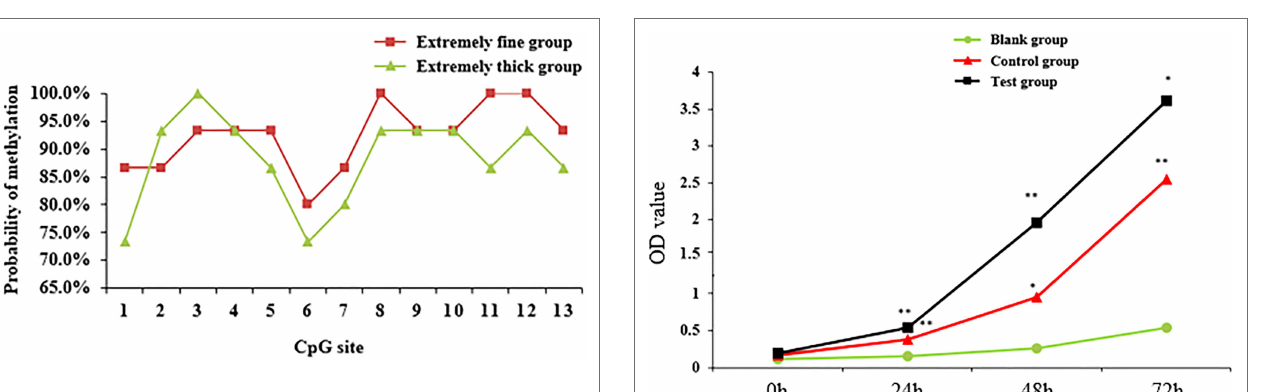
FIGURE 10 | DNA methylation level of CpG loci of WNT2 gene in skin tissue of Super Merino Sheep with different fineness.